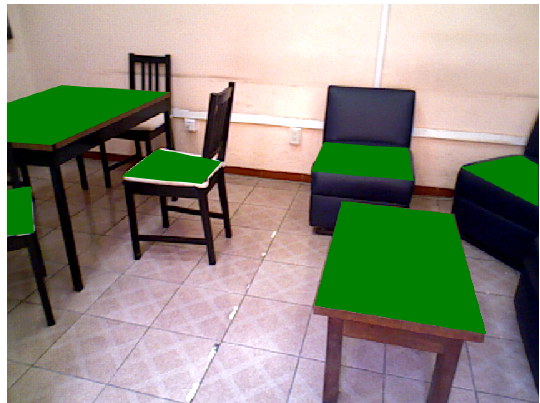
Figure 2. Common scene of a home environment. Each object’s horizontal plane is indicated with